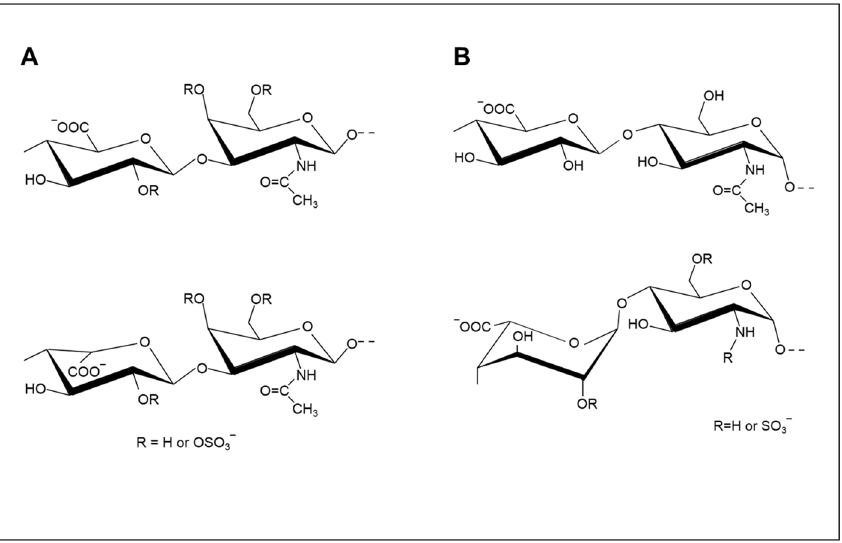
Figure 1. Typical repeating disaccharides of chondroitin (( A ), upper) and dermatan (( A ), lower) sulfates (( A ), lower) and repeating disaccharides of heparan sulfate (( B ), upper) and heparin (( B ),